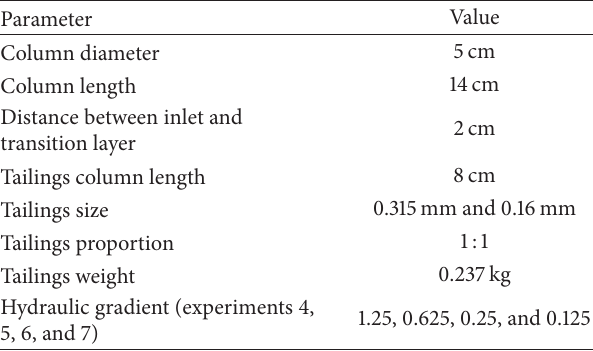
Table 3: Characteristics of the physical column experiments.